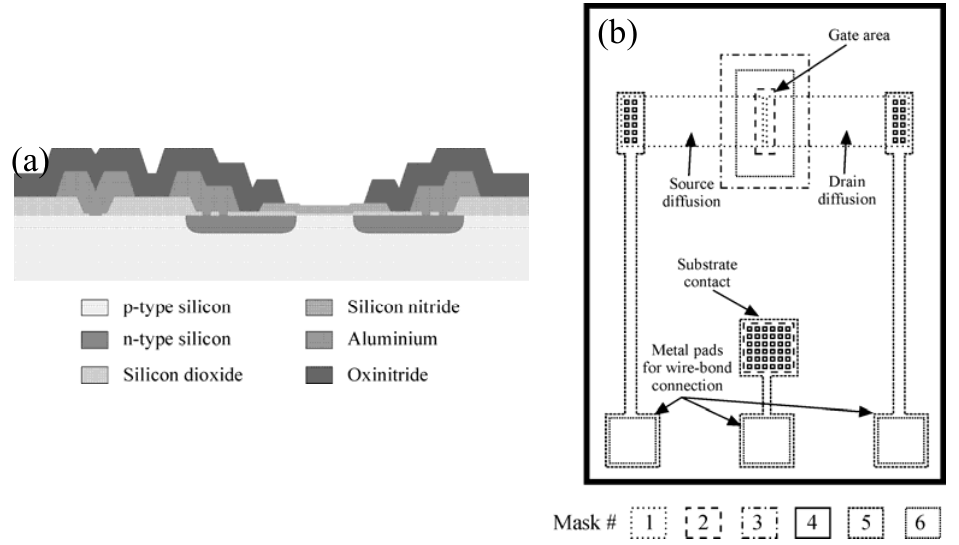
Figure 1. (a) Cross-sectional schematic representation of the NMOS ISFET. (b) Fabrication masks for NMOS ISFETs.